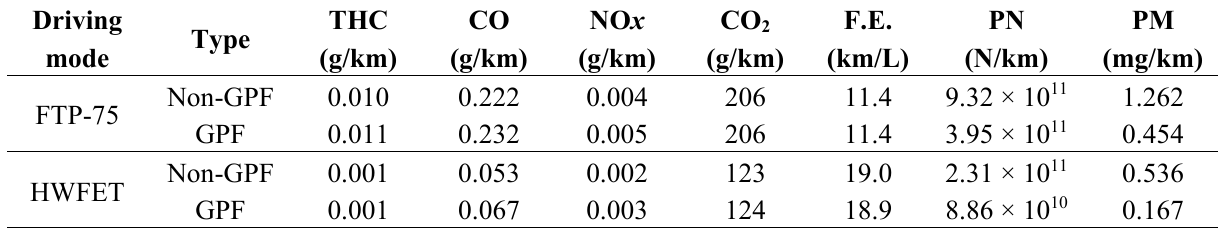
Table 4. Regulated emissions, CO 2 , fuel economy, and